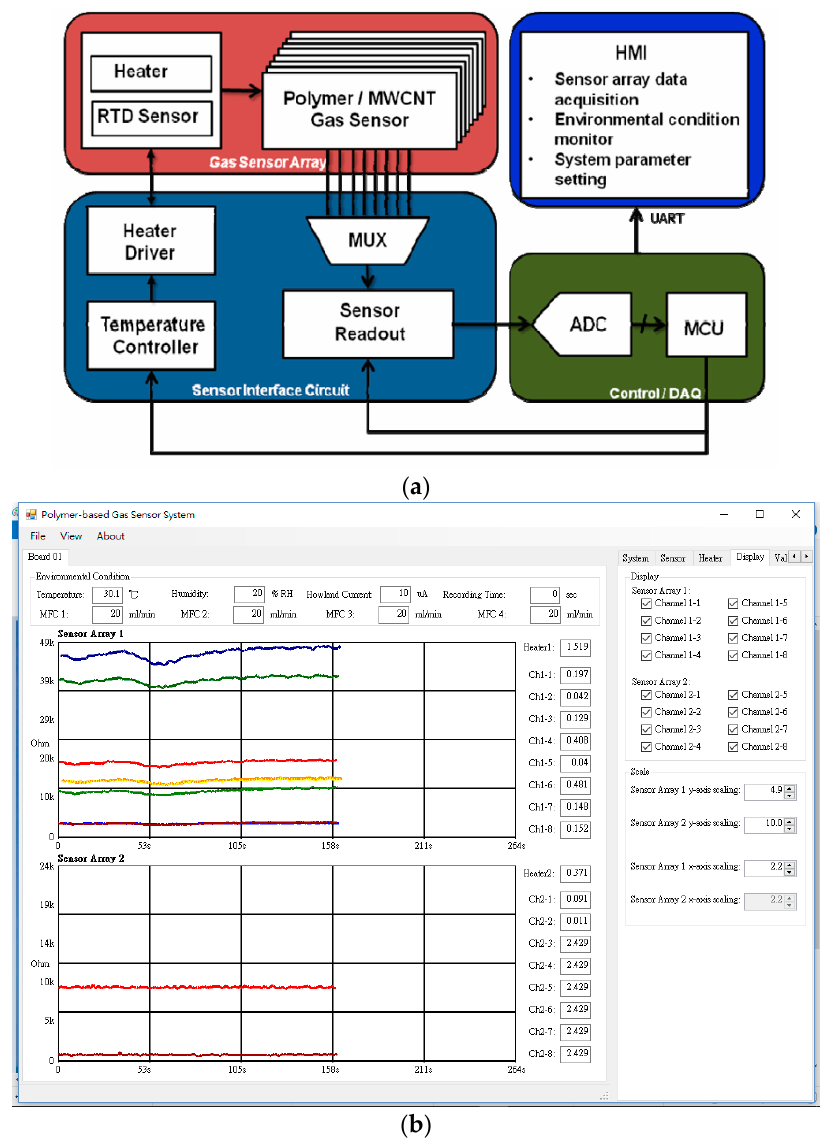
Figure 3. ( a ) system block of the gas sensor array control system; and ( b ) human–machine interface software.